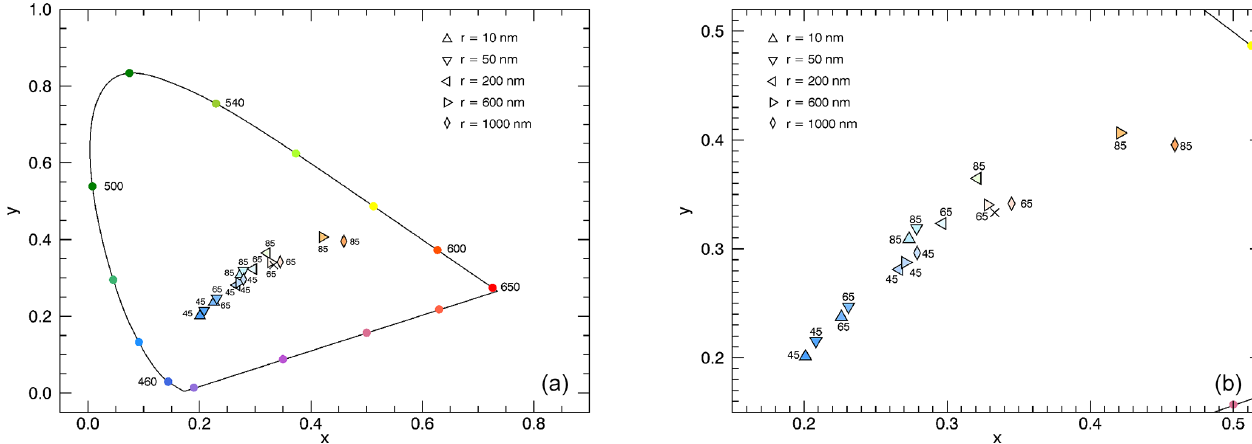
Figure 8. CIE chromaticity diagram for simulations with NLCs and different median radii of the NLC particle size distribution. Marked at the data points are the following: VZAs = 45, 65 and 85 ◦ , with SZA = 98 ◦ and SAA = 0 ◦ . The width parameter of the size distribution is S = 1 . 4, and the optical depth is τ NLC = 10 − 4 . Panel (b) shows an enlarged version.